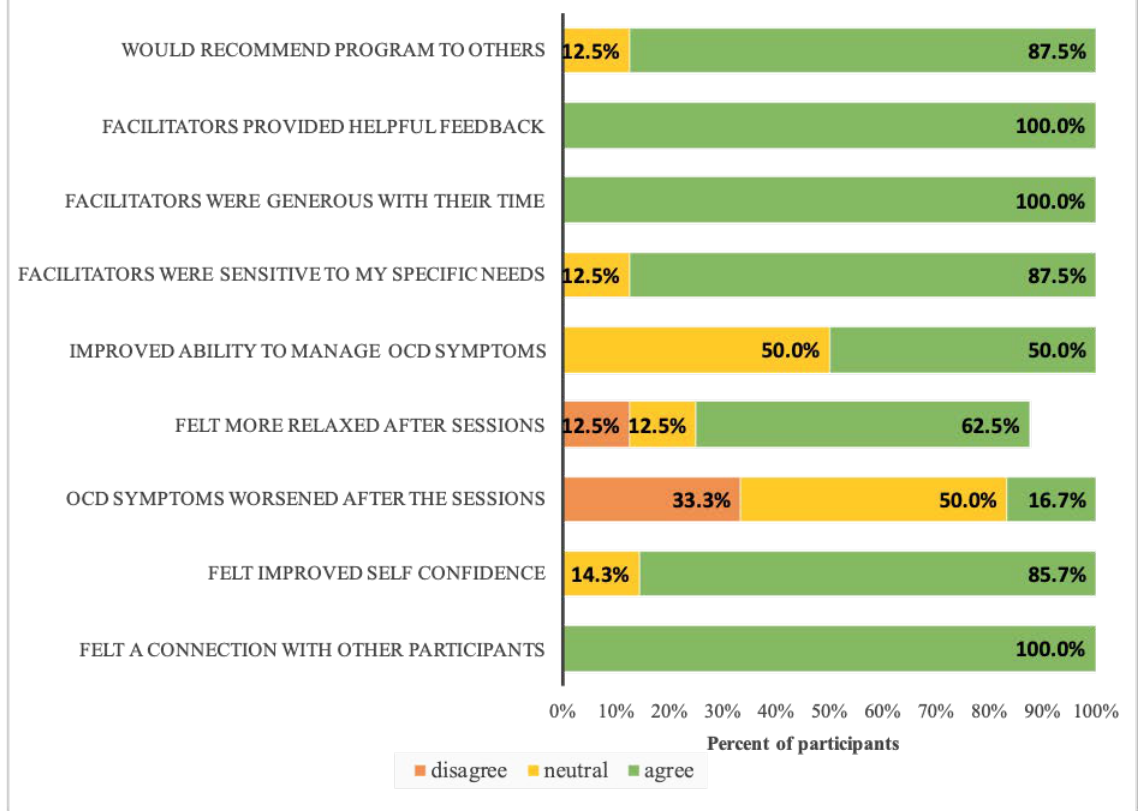
Figure 3. Results of the post-performance survey of “Inside OCD” group members ( n =